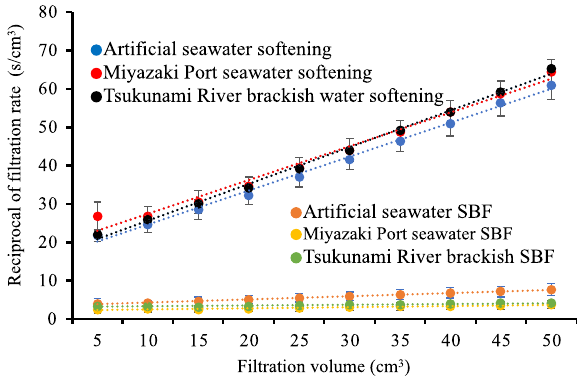
Fig. 7 Comparison of sludge dehydration in arti fi cial and actual seawater samples after conventional softening and softening with ballasted fl occulation (SBF), obtained in a Buchner funnel test ( n = 3, means ± standard